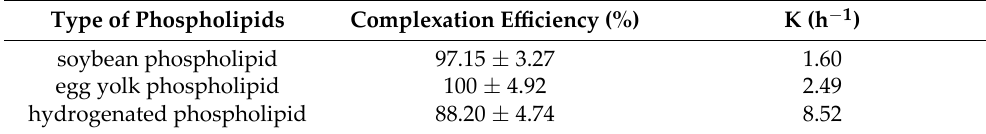
Table 1. Complexation efficiency and dissociation rate of GTP-PC of different types of phospholipids.